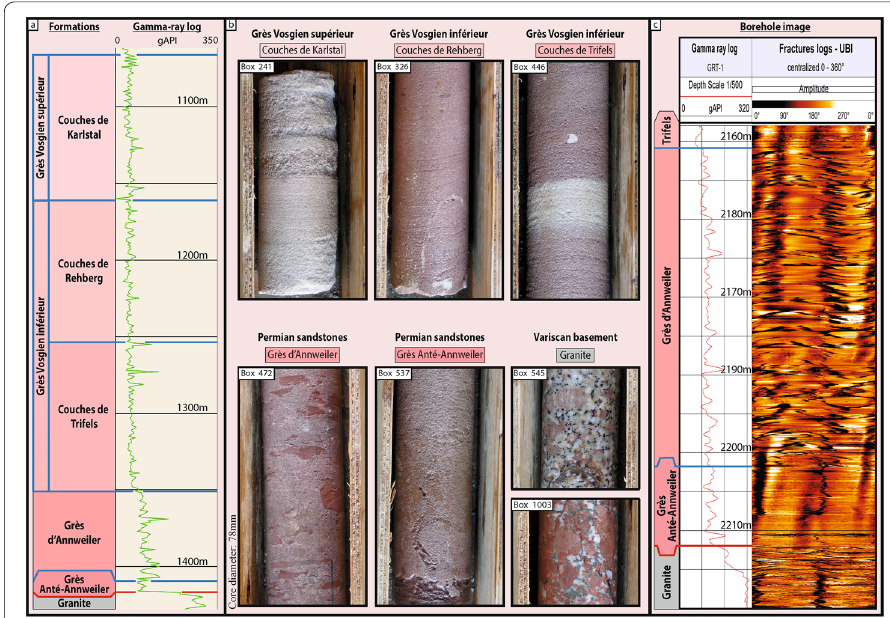
facies sandstone typical from the Couches de Karlstal. Box 326, Couches de Rehberg: coarse sandstone with white quartz pebbles and a filled fracture (white circular arc). Box 446, Couches de Trifels: coarse-grained sandstone with white quartz pebbles and a decolored level. Box 472, Grès d’Annweiler: clayey sandstone with high frequency rip-up clay clasts of all sizes rounded or angular. Box 537, Grès d’Anté-Annweiler: coarse-grained clayey arkosic sandstones with a thick clay level at the base. Boxes 545 and 1003, Variscan granitic basement: unaltered monzogranite with K-feldspar megacrystals and oxidized facies, respectively. c GRT-1 GR log and borehole image log showing unrolled vertically compressed image of the